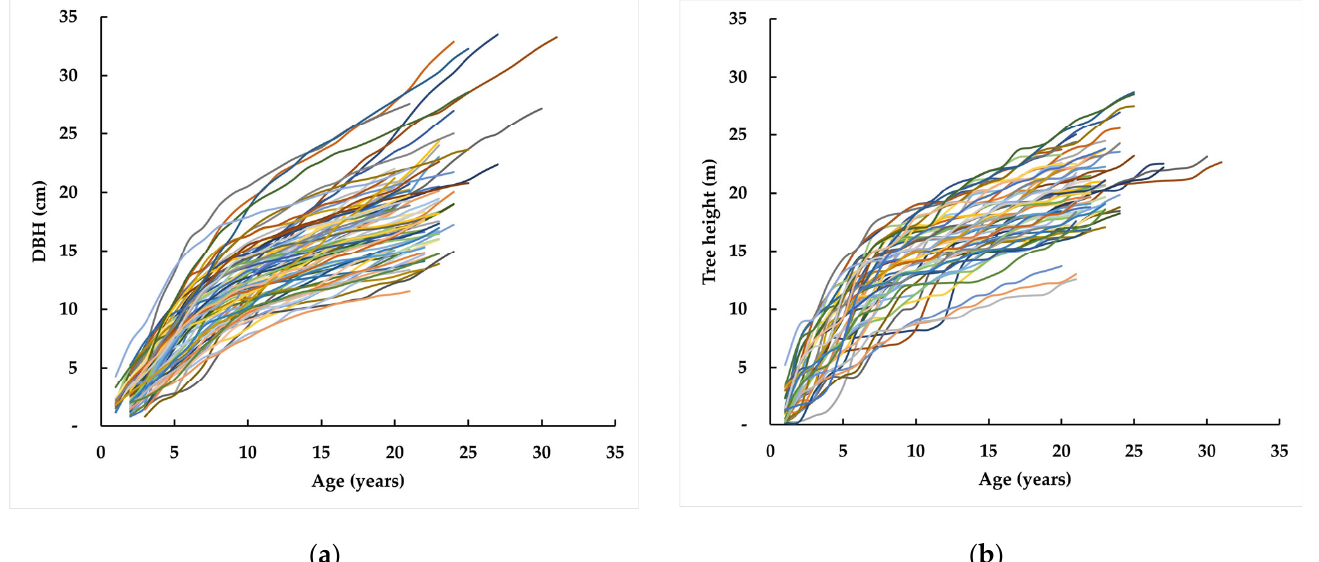
Figure 3. Stem analysis profile plots; DBH versus age ( a ); tree height versus age ( b ). Topographic conditions of the sample plots including coordinates and elevation (EV) were recorded with the aid of a global positioning system receiver (GPSMAP64, Garmin); slope gradient (SG, %) and slope direction (SD) were measured using a clinometer with SD scored as north (1), east (2), south (3) and west (4). The slope position (SP) was scored as bottom (1), lower (2), middle (3), upper (4) and crest (5). The slope form (SF) classes for this study included straight (S), concave (C) and convex (V) based on the general shape